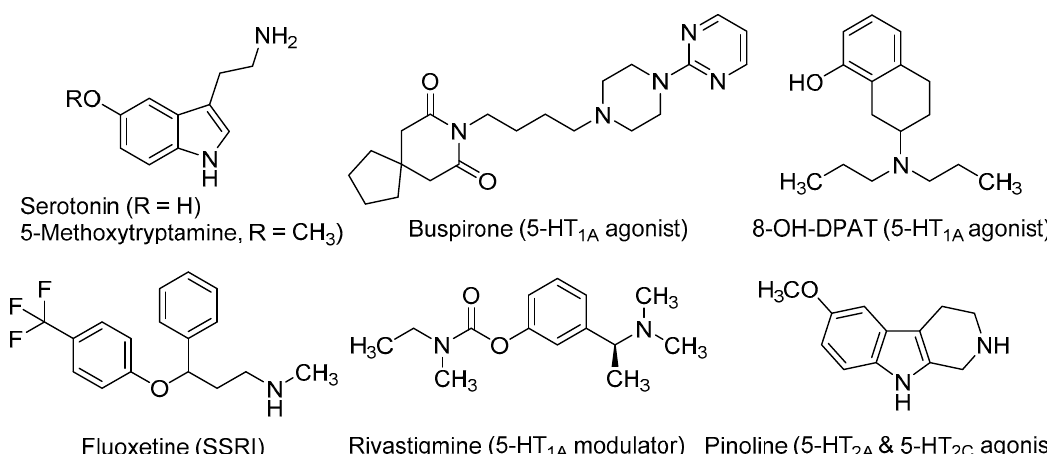
Figure 1. Serotonergic ligands with neurogenic properties.